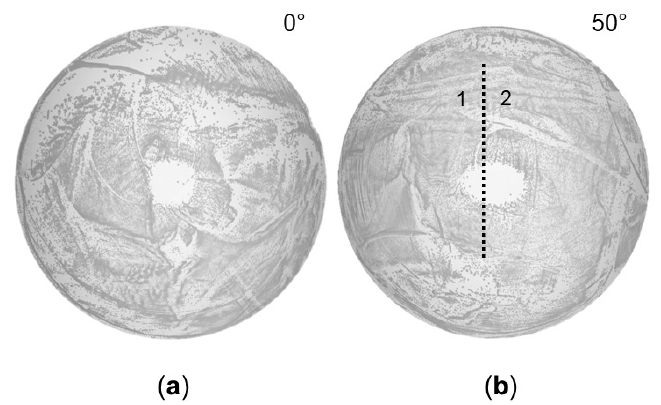
Figure 5. Effective treatment area of kINPen ® MED- β visualized by inhibition zone assay at 8.5 mm distance after 45 s plasma treatment for ( a ) perpendicular treatment and ( b ) an incidence angle of 50 ◦ (side 1: inclination of the kINPen ® MED- β as shown in Figure 2c, side 2: area with plasma plume propagation); test bacterium: Staphylococcus aureus DSM 799 / ATCC